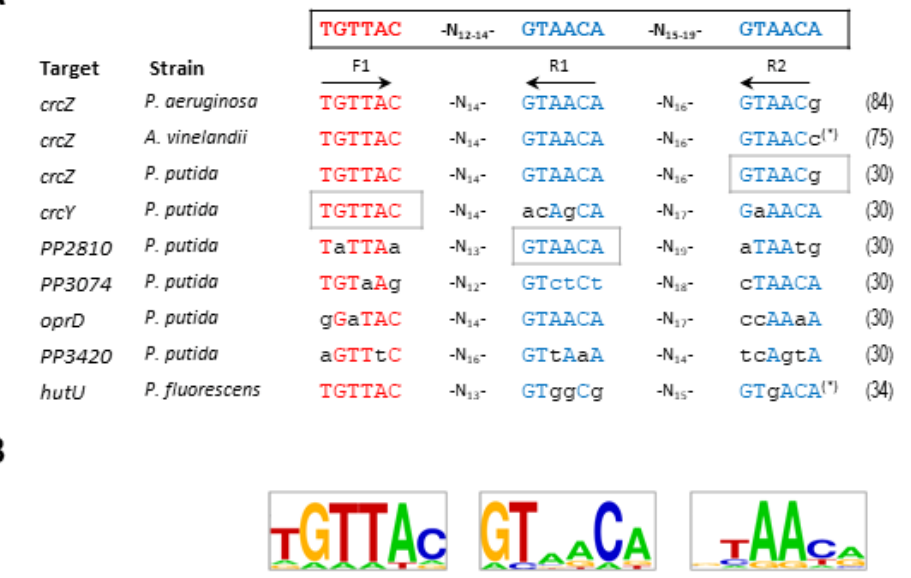
Figure 3. ( A ) Sequence alignment of the putative CbrB binding subsites for those targets that have been experimentally shown by mutagenesis to be CbrAB controlled in different organisms. The consensus sequence and orientation are shown at the top. Colored sequences in uppercase coincide with the proposed consensus. In grey boxes are the most relevant subsites for transcriptional activation for crcZ , crcY and PP2810 in P. putida . The asterisk (*) shows that the consensus sequence established by the authors has been re-evaluated in this work and the third binding subsite is proposed at the indicated distance. ( B ) LOGO sequence obtained from the sequences experimentally assayed as CbrB binding sites.